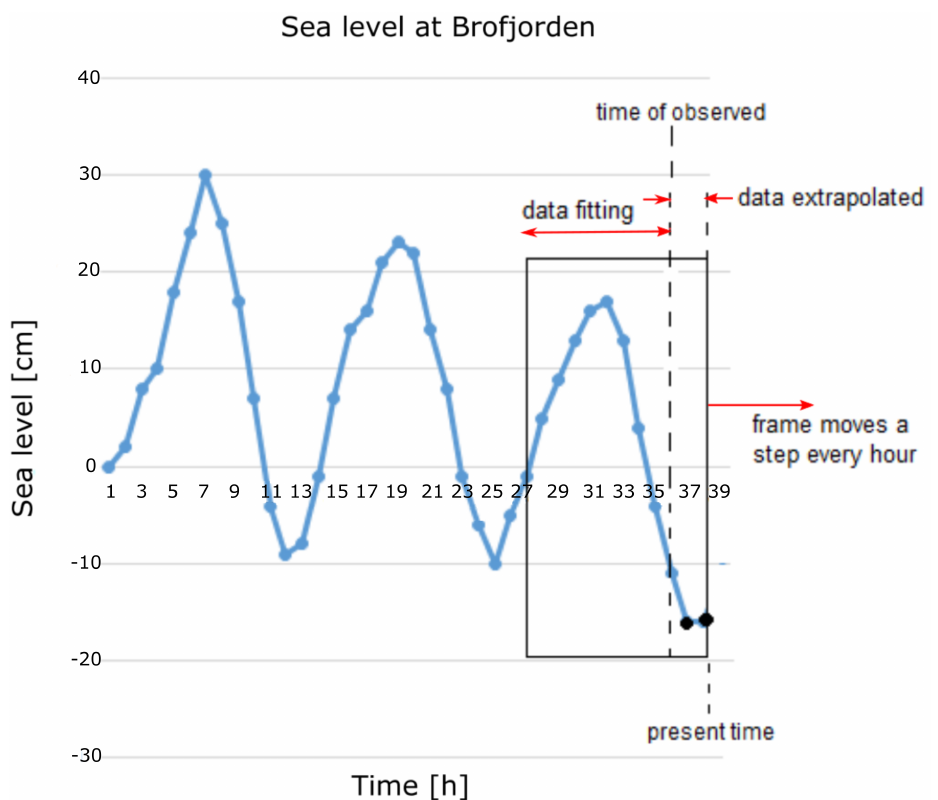
Figure 4. Illustration of 2-h extrapolation based on a sinusoidal fitting for 10 h of observed sea levels. The rectangular frame shows how 10 observations were used to extrapolate the subsequent data point. The least-squares minimization method [17] was used to fit these 10 observations to get the best fit of a sine function. The acquired sine function was then used to extrapolate the next 2 h of data points every hour (up to the present time) (see Figure 4). The frame was shifted one hour when new observational data were obtained from the SMHI. This process was repeated to predict the